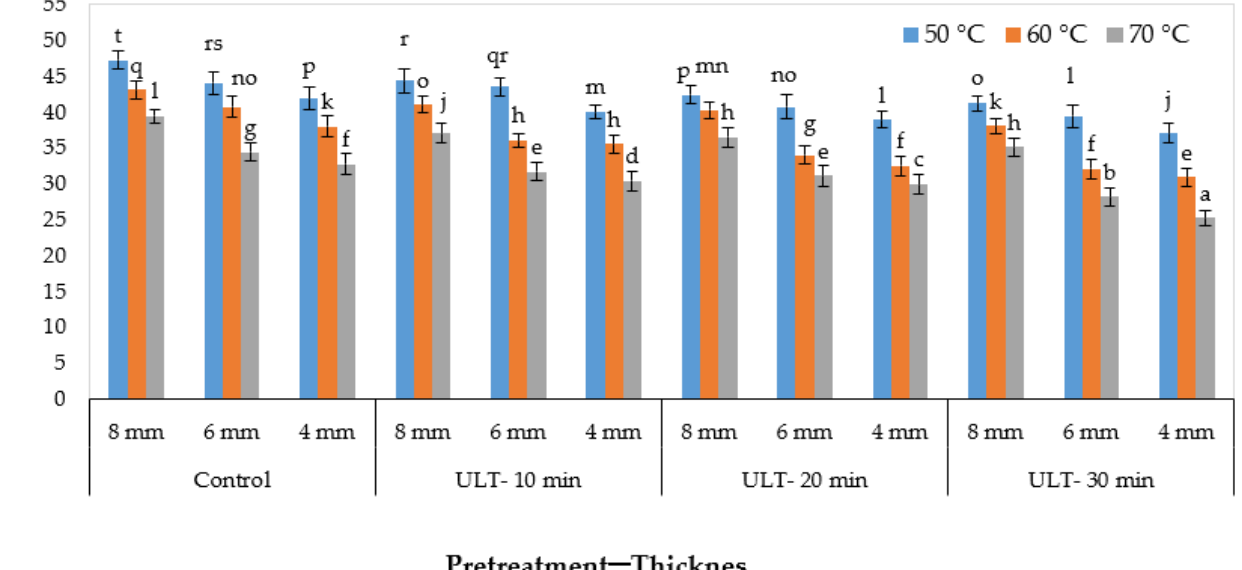
Figure 8. Shrinkage of kiwifruit slices under different drying conditions.